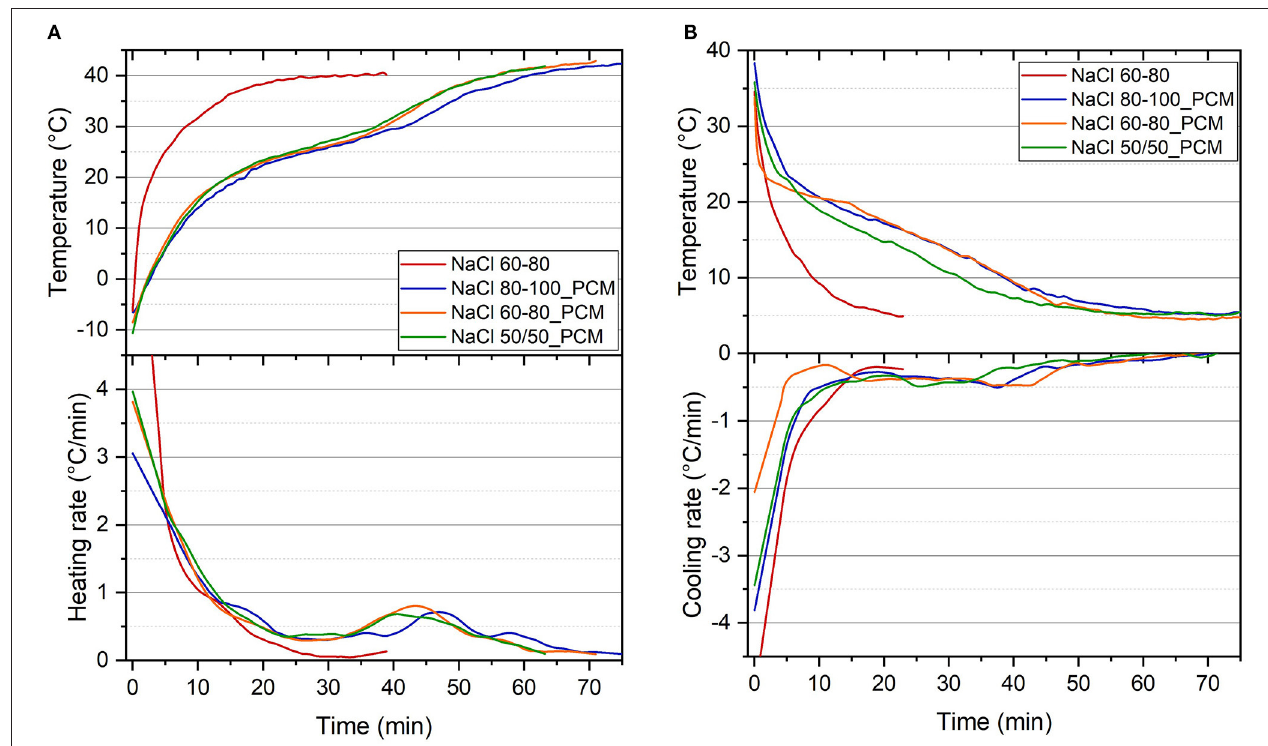
FIGURE 7 | Surface temperature profiles of the EPDM and TES-EPDM foams, and correspondent rate of thermal variation after the thermal imaging tests in (A) heating stage from − 20 to 40 ◦ C and (B) cooling stage from 40 to 5 ◦ C in 75min.